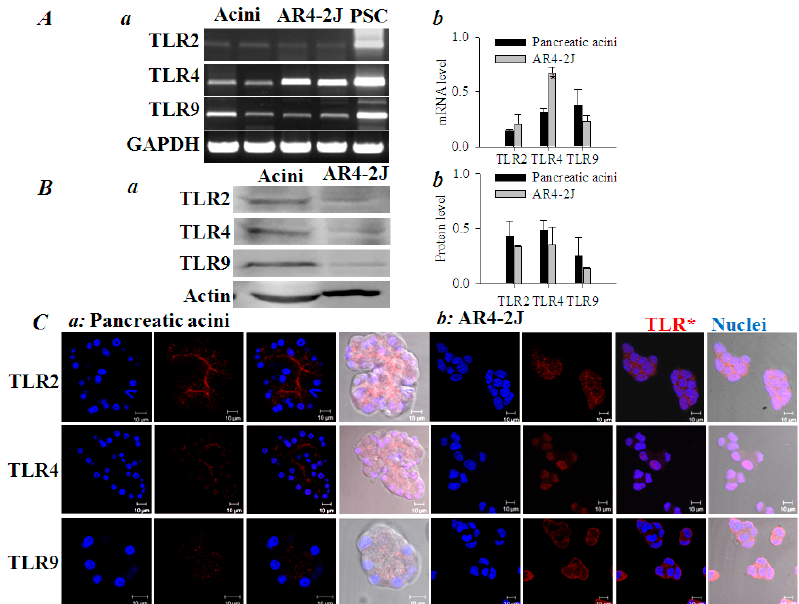
Figure 4. Expression of TLR2, TLR4, TLR9 in pancreatic acini and in AR4 ‐ 2J cell clusters as determined by RT ‐ PCR, Western blot and immunocytochemistry. ( A ) RT ‐ PCR determination of TLR2, 4 and 9 ( Aa ). Activated pancreatic stellate cells (PSC) were used as positive controls. Lanes for acini or AR4 ‐ 2J in the images were done with pancreatic acini from two different rats, or from two different AR4 ‐ 2J cultures. TLR2, 4 and 9 mRNA contents normalized to that of GAPDH were quantified both in rat pancreatic acini and in AR ‐ 2J ( Ab ). ( B ) Protein extracts from rat pancreatic acini or AR4 ‐ 2J were separated by SDS ‐ PAGE, and Western blot was done using antibodies against TLR2, 4 and 9. The β‐ actin was used as internal controls ( Ba ). TLR2, 4 and 9 and β‐ actin bands in blots from ≥ 3 rats or ≥ 3 AR4 ‐ 2J cultures were quantified by ImageJ; TLR2, 4 and 9 protein levels were expressed as ratios of TLR/ β‐ actin. No statistically significant differences were found ( P > 0.05, Bb ). ( C ) Rat pancreatic acini or AR4 ‐ 2J were fixed for immunocytochemistry. Antibodies against TLR2, 4 and 9 and TRITC ‐ conjugated secondary antibody were used (red). The nucleus was counter ‐ stained with Hoechst 33342 (blue). Confocal images were taken (Zeiss 700) with λ ex 555 nm (TRITC) or 405 nm (Hoechst 33342), λ em 576 nm and 461 nm respectively. Images from one typical experiment are shown. Scale bars: 10 μ m. Both fluorescent and merged images are presented.